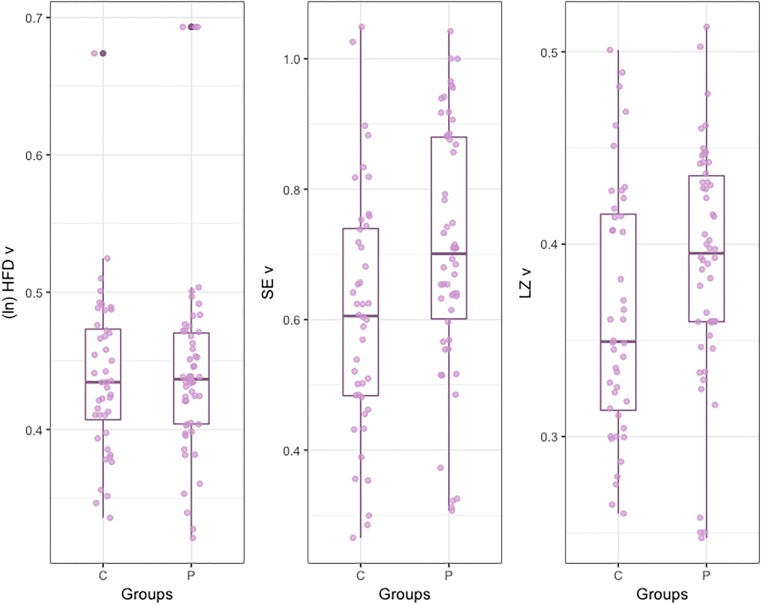
Box Plot for complexity measures for velocity.